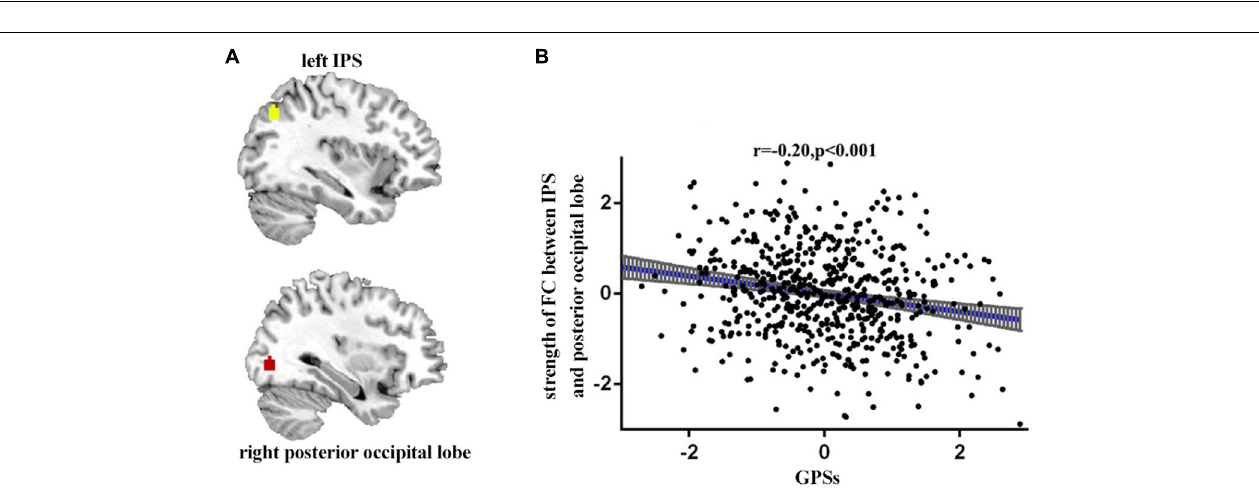
FIGURE 2 | The functional connectivity between the left IPS ( x = –36, y = –69, z = 40) and the right posterior occipital lobe ( x = 33, y = –81, z = v2). Participants with high GPSs showed significantly lower RSFC in these regions (A) . Scatter plots of the correlations between GPSs and the functional connectivity (B)